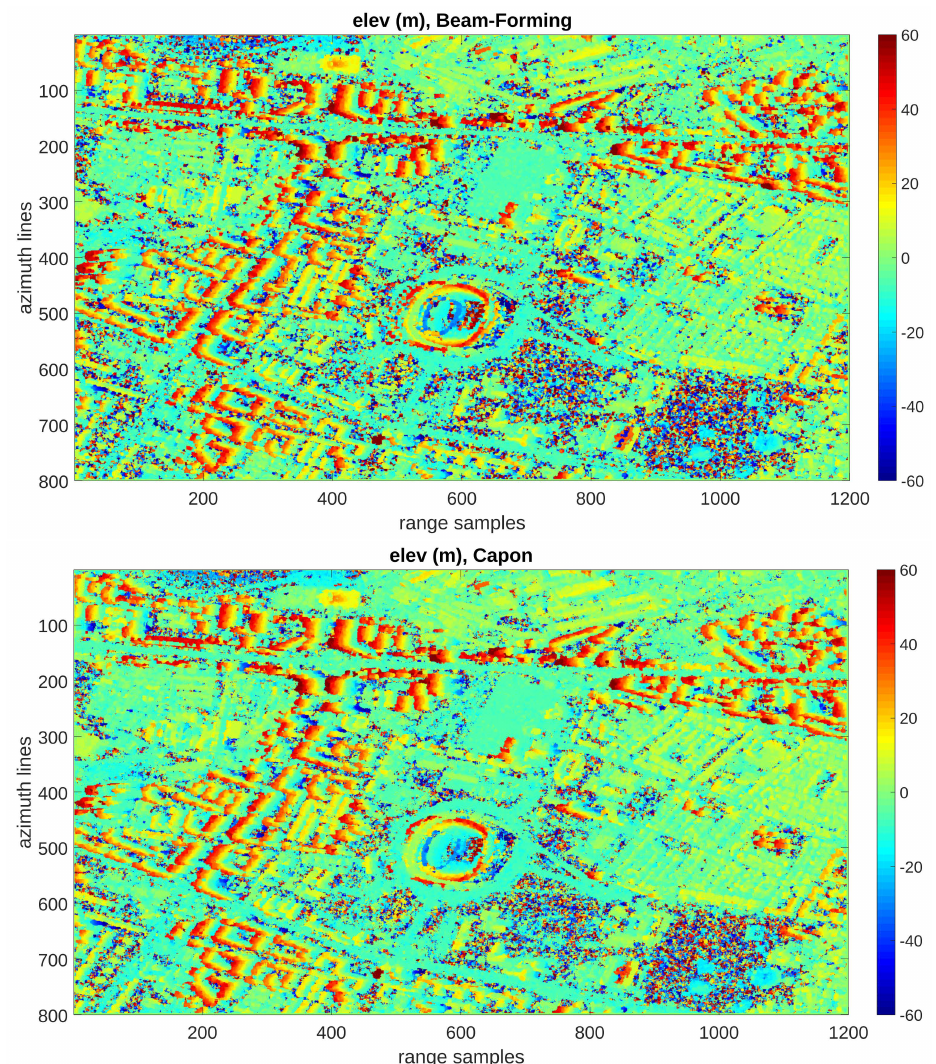
Figure 3. Maps of the estimated dominant scatterers elevation, corresponding to the peaks of the BF ( a ) and Capon ( b ) reconstructions. Colormap is in meters and set according to the estimated